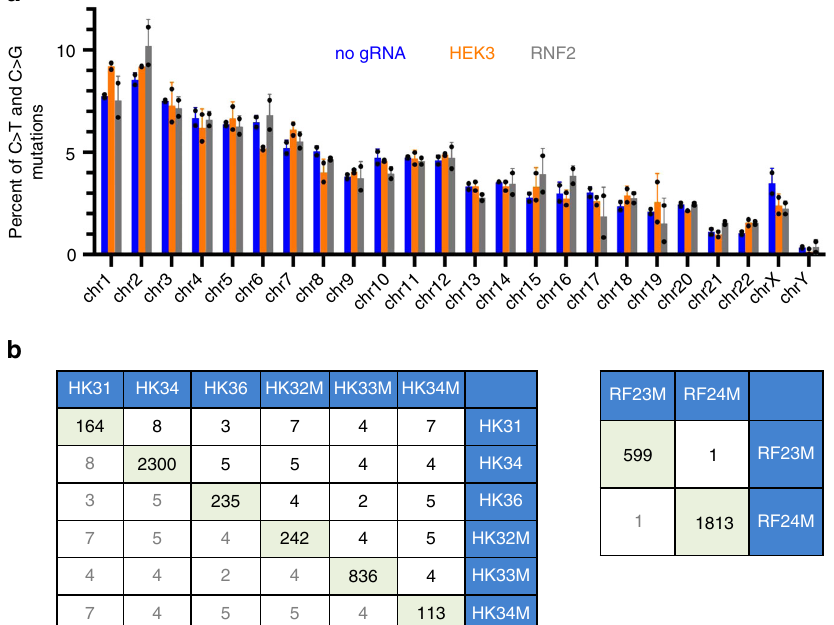
Fig. 4 The off-target mutations are randomly distributed. a Chromosomal distribution of C:G>T:A and C:G>G:C mutations in iPSC clones that each has >500 total mutations. Error bar represents standard deviation ( n = 2). Source data are provided in the Source Data fi le. b Numbers of mutation overlaps between iPSC clones edited at either HEK3 or RNF2 locus. The numbers of mutations include on-target mutation(s). A complete comparison of mutations among all sequenced iPSC clones is shown in Supplementary Table